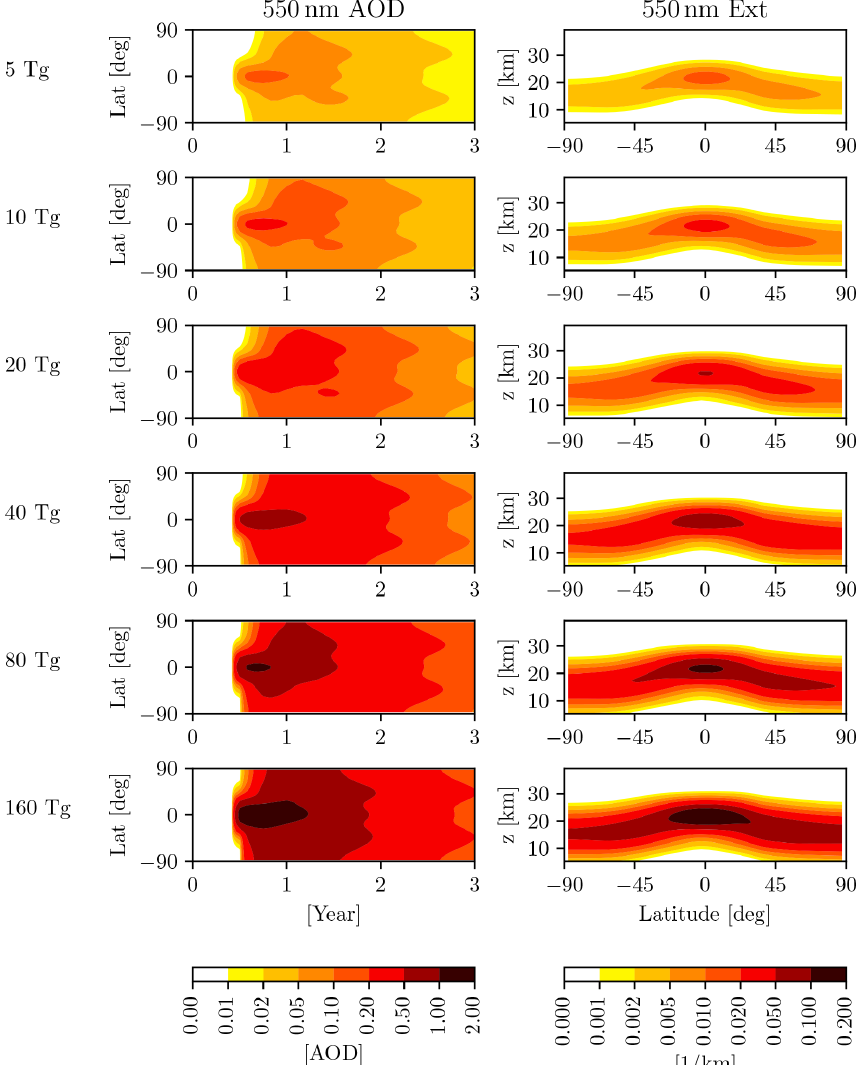
Figure 1. The EVA aerosols for eruptions used in this study. All eruptions are in June and at the Equator, with injections of 5, 10, 20, 40, 80, and 160Tg(S), from top to bottom. Left column: zonally averaged, 550nm aerosol optical depth (AOD) for the first 3 years of forcing. Right column: zonally averaged, latitude–height distribution of extinction coefficients (Ext), averaged over the first winter (December–January– February) following the June eruptions. Rows are labeled by the mass (in Tg) of the sulfur